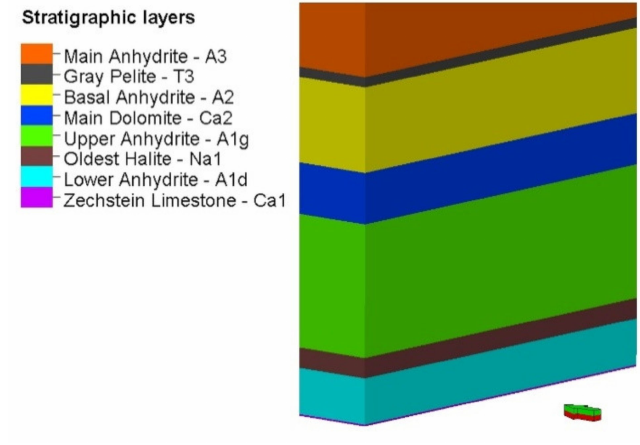
Figure 22. Layer structure of the